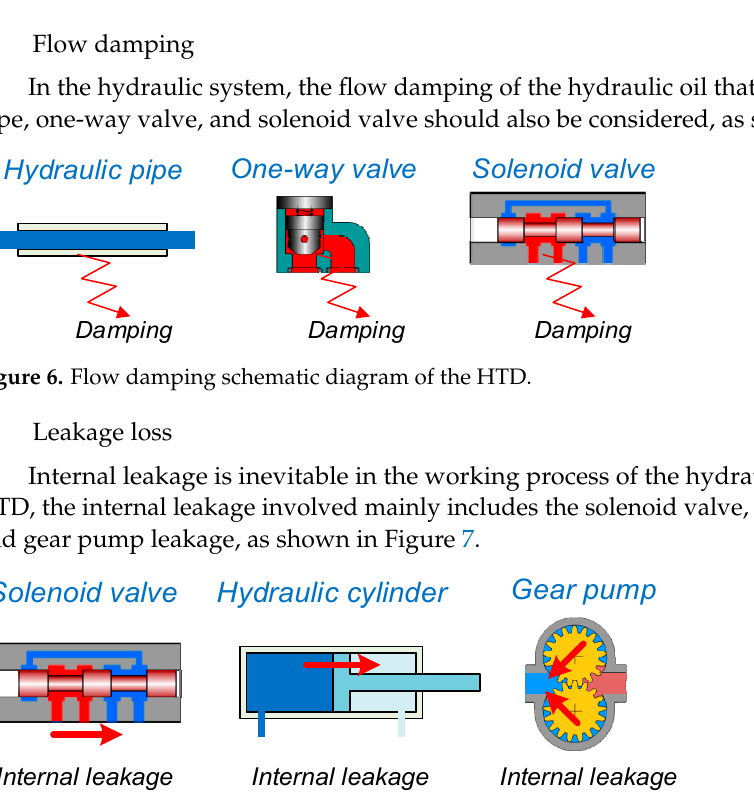
Damping Figure 5. Motion damping schematic diagram of the HTD. 2. Flow damping In the hydraulic system, the flow damping of the hydraulic oil that flows through the pipe, one-way valve, and solenoid valve should also be considered, as shown in Figure 6. Damping Solenoid valve Figure 6. Flow damping schematic diagram of the HTD.